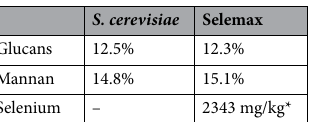
Table 2. Supplements composition. *2343 mg of selenium per kg of S. cerevisiae